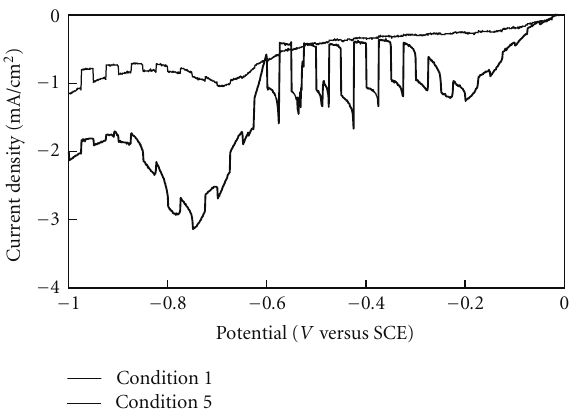
Figure 4: Results of the PEC measurement for the films deposited under condition 1 and condition 5. The step-form variation in the current is due to the turning on/o ff of the illumination. The observed photocurrent is negative for both the